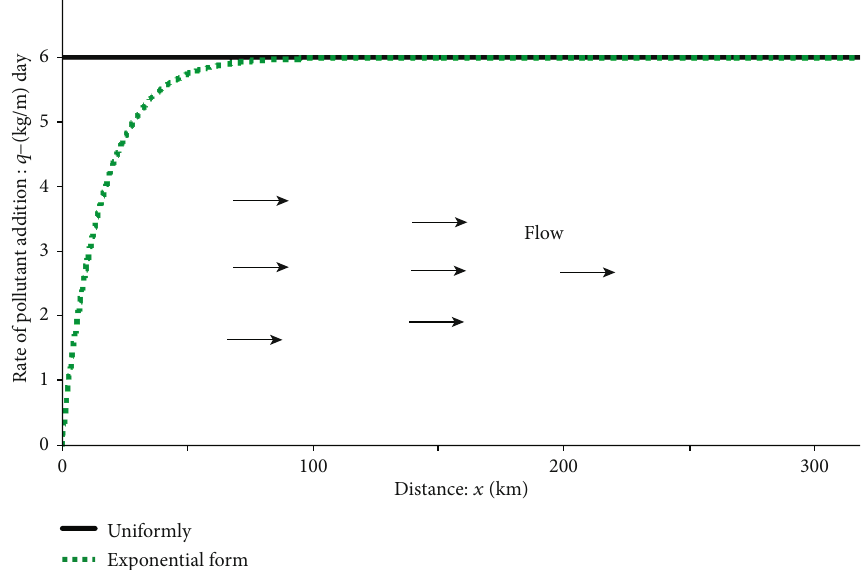
Figure 2: Physical system of the rate of pollutant addition q